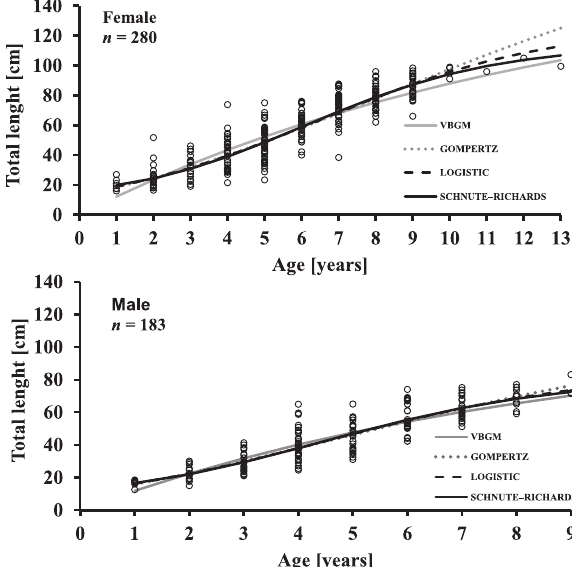
Table 4. Akaike’s information criterion (AIC) values, AIC dif- ferences, and AIC weight of the candidate models to describe the trend of the age–length data of the Pacific hake, Merluccius productus , by sex.